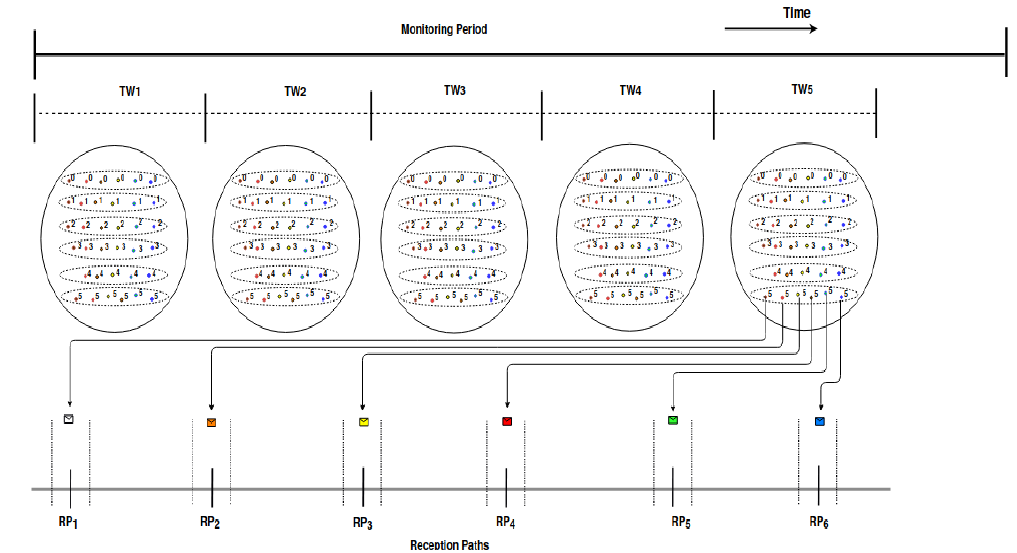
Figure 3. Time diagram of transmissions with